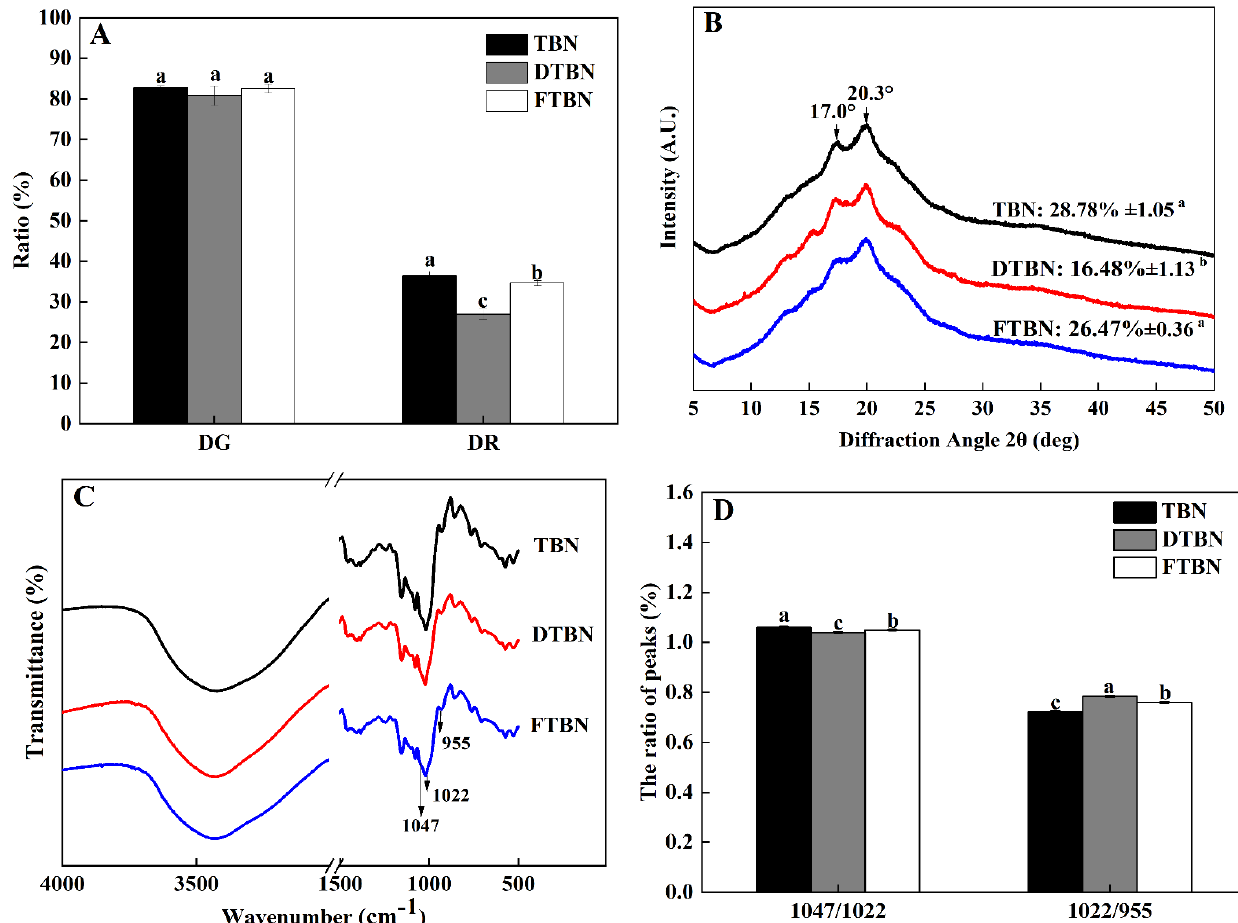
Figure 3. Changes in starch properties and the structure of Tartary buckwheat noodles. Starch gelatinization and retrogradation ( A ); X-ray diffraction ( B ); Fourier transform infrared ( C ); the absorbance ratios at 1047/1022 and 1022/955 cm −1 ( D ). DG, degree of starch gelatinization; DR, degree of starch retrogradation; TBN, fresh Tartary buckwheat noodles; DTBN, dried Tartary buckwheat noodles; FTBN, frozen Tartary buckwheat noodles. Different letters in the same figure imply that the values are significantly different ( p < 0.05).